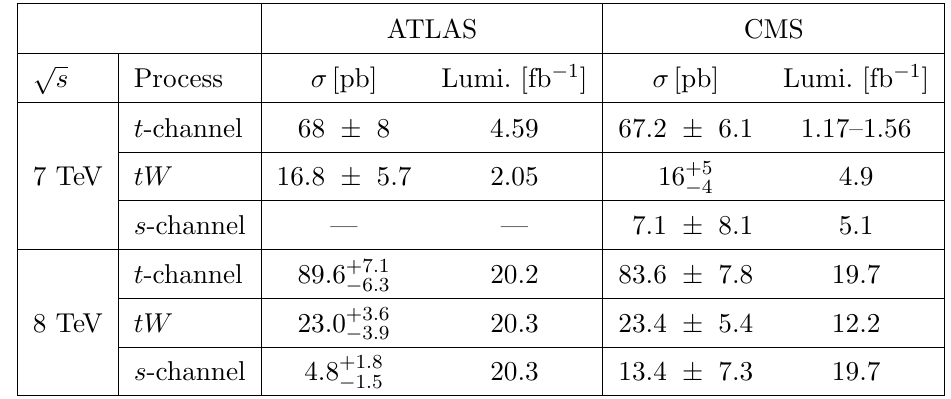
Table 2 . Summary of the single-top-quark cross-section measurements published by the ATLAS and CMS Collaborations at p s = 7 and 8 TeV. Total uncertainties are shown. Small di(cid:11)erences between the integrated luminosity values in di(cid:11)erent analyses within the same experiment and centre-of-mass energy are due to di(cid:11)erent luminosity calibrations at the time of publication. in the signal region and the lepton-charge distribution in the W +jets control region. The CMS t -channel measurement at p s = 8 TeV is based on a simultaneous (cid:12)t to the absolute pseudorapidity ( (cid:17) ) distributions of the recoiling light-(cid:13)avour jet in events with negative